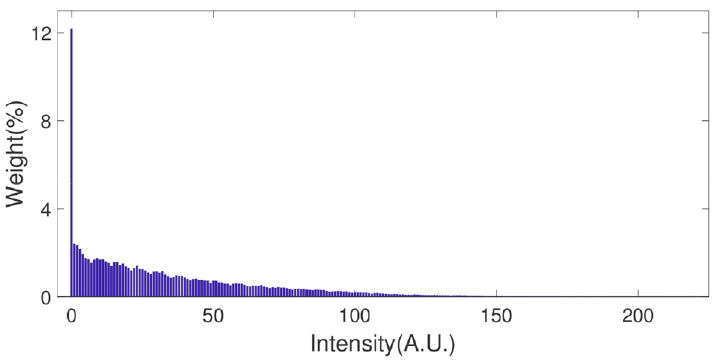
Figure 4. Intensity statistical